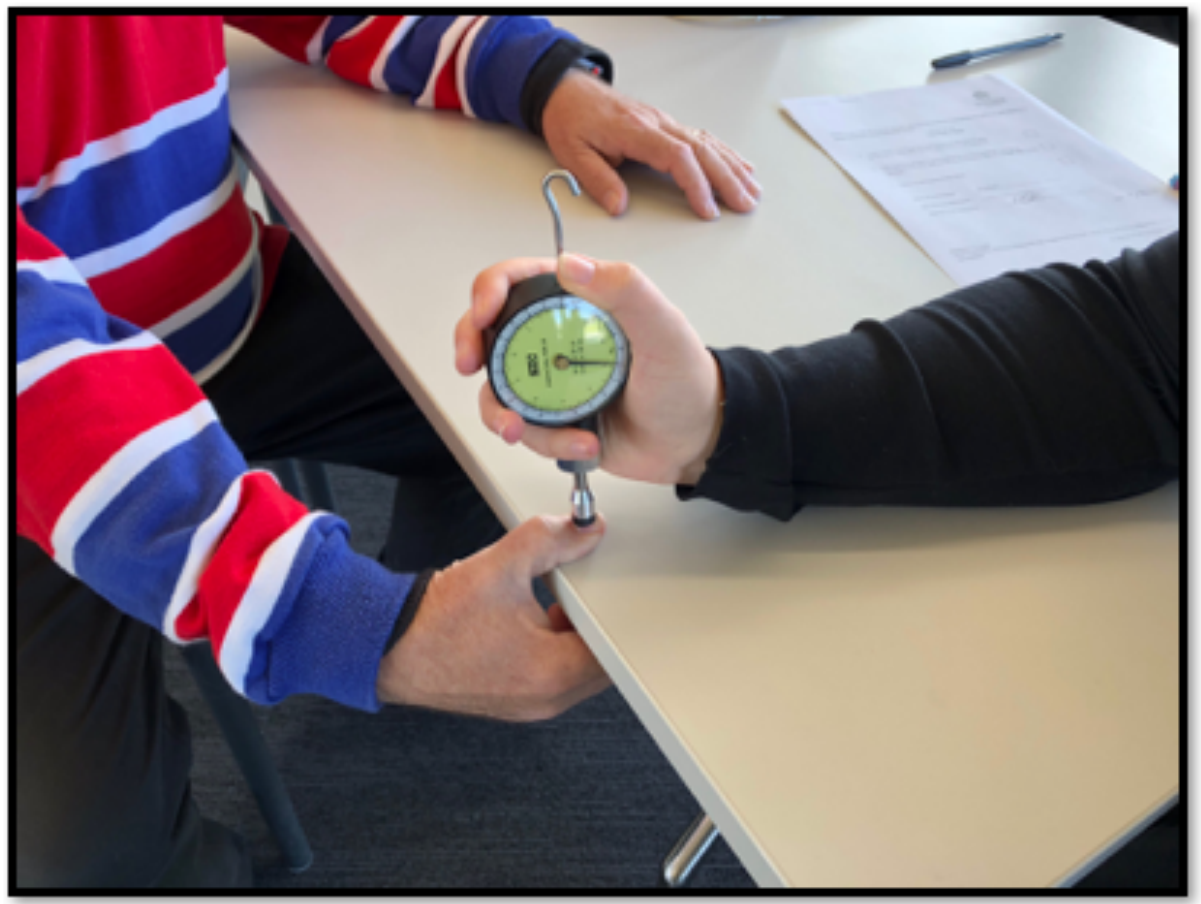
Figure 1. Wagner Force Dial pressure applied on the participant’s